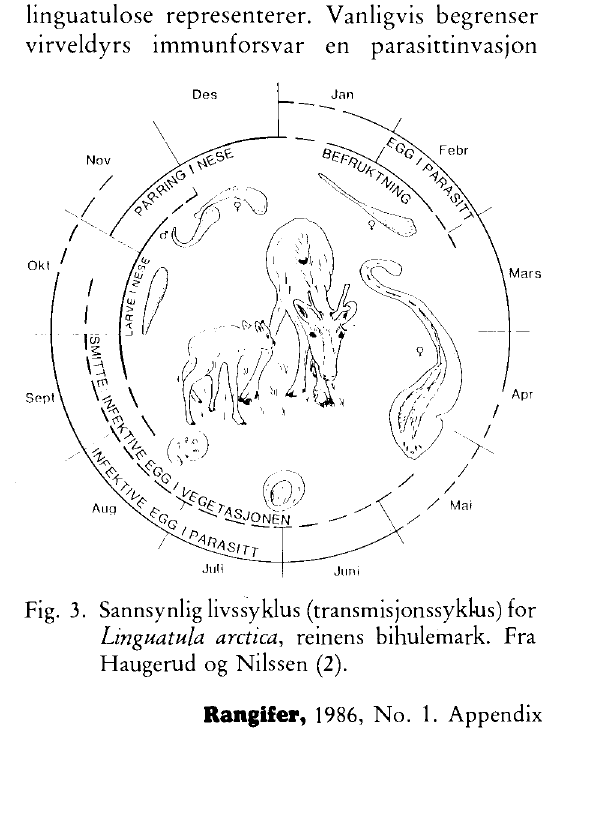
Fig. 2. Livssyklus (transmisjonssyklus) for Lingua tula serrata, hundens tungemark. Utarbeidet til 12th Sean. Symp. Parasitol, Tromsø 1985. Sterkt modifisert etter (68, 69).